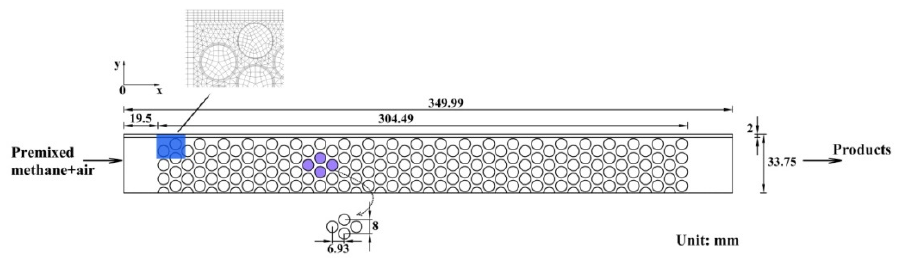
Figure 4. Computational domain and